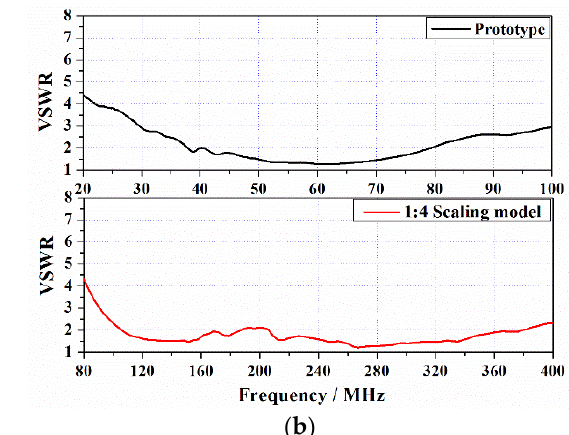
Figure 8. Structure and test of the scaled model. ( a ) Scaled model of the antenna and Rover. ( b ) VSWR comparison between prototype and scaled model.